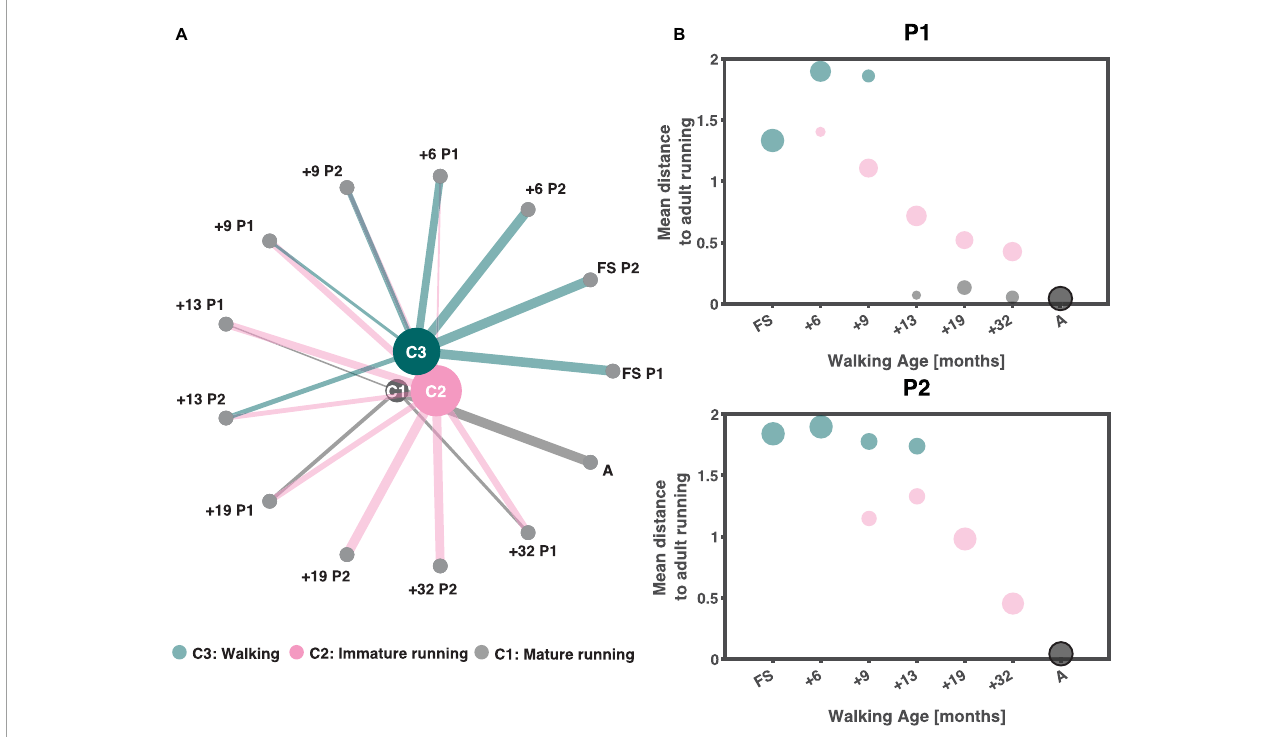
FIGURE4 Clustering output. (A) Output of clustering ordered based on walking age (time since onset of walking in months) with the youngest session on the right and increasing in walking age in anticlockwise direction. The size of the clusters depends on the number of strides they contain (the larger the node the more strides they contain), similarly are the lines from each node to a cluster a representation of the number of strides (thicker lines equals more strides) from that session that belongs to each cluster larger than 10%. (B) Average pairwise correlation distance from each session to those of the adults as a function of walking age (months) for P1 and P2, respectively. Sizing of dots follow the sizing of lines in panel. A: adults, FS: first steps, +6, +9, +13, +19, +32 refers to the number of months since onset of independent